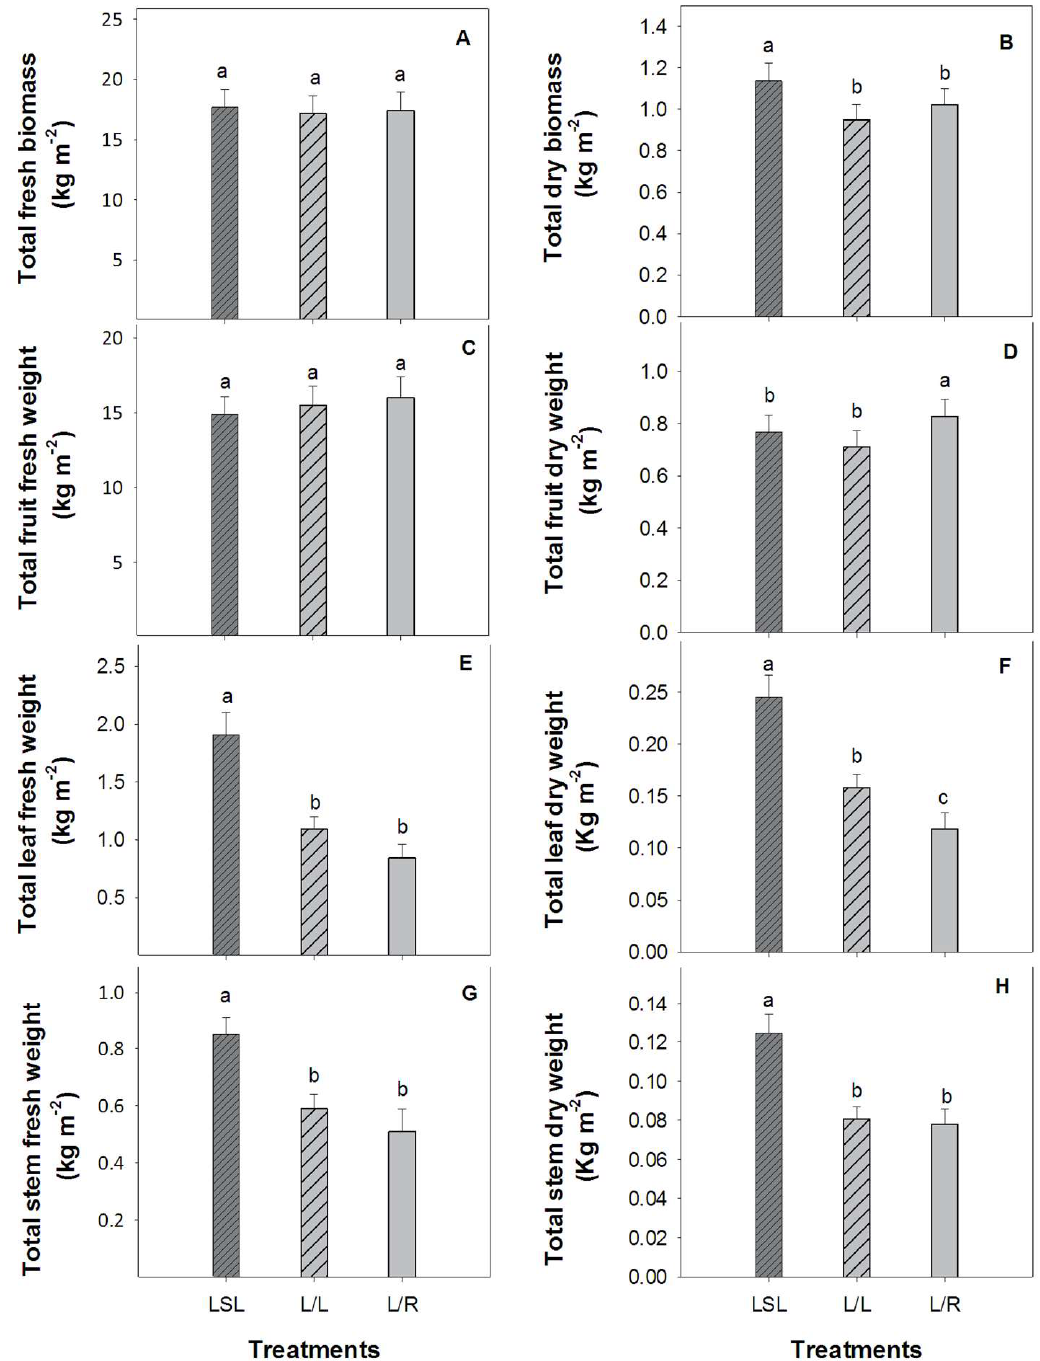
Figure 3. Total fresh biomass ( A ), total dry biomass ( B ), total fresh fruit weight ( C ), total dry fruit weight ( D ), total leaf fresh weight ( E ), total leaf dry weight ( F ), total fresh stem weight ( G ), and total dry stem weight ( H ) (kg m − 2 ) for plants corresponding to treatments LSL (long-shelf-life tomato), L/L (self-grafted Old Limachino tomato) and L/R (grafted Old Limachino tomato on Poncho Negro rootstock). All parameters were expressed in kg m − 2 under greenhouse conditions. Each value represents the mean ± SE ( n = 12). Lower-case letters indicate differences ( p ≤ 0.05, Duncan test) among treatments.